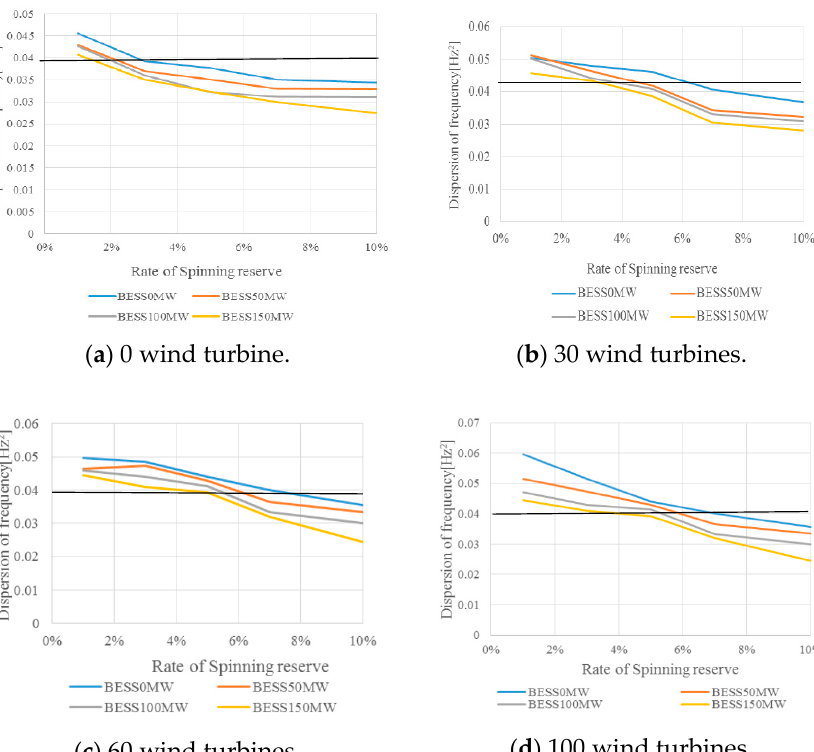
Figure 13. Rate of dispersion under ±1 of 10 m/s wind turbine.